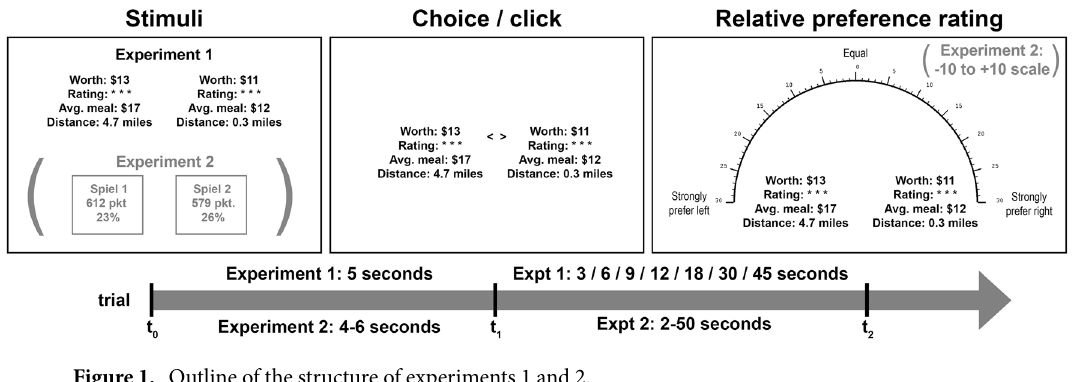
Figure 1. Outline of the structure of experiments 1 and